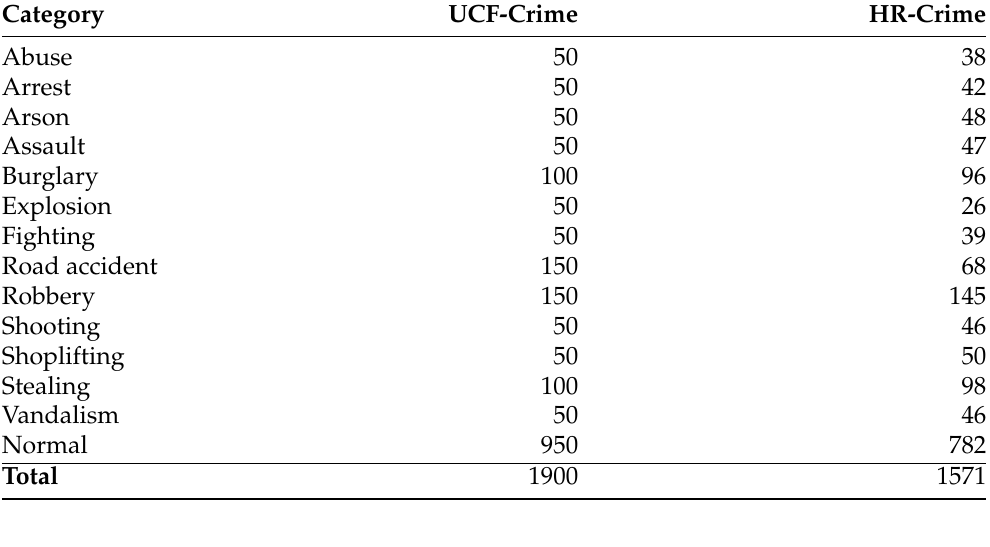
Table 8. The number of videos in the UCF-Crime dataset.